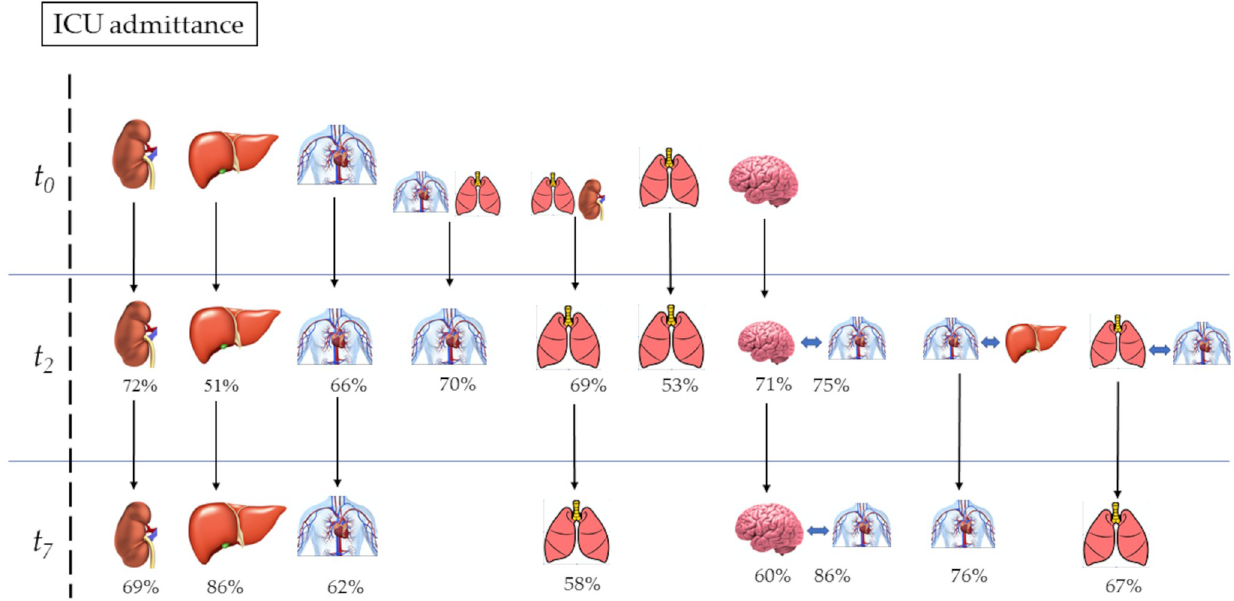
Fig 2. Percentage probabilities of the organ failure progression. The day of the intensive care unit admission: t 0 ; the 2nd day after the intensive care unit admission: t 2 ; the 7th day after the intensive care unit admission: t 7 . Percentage numbers: conditioned probability to progress at 2 nd and 7 day th .